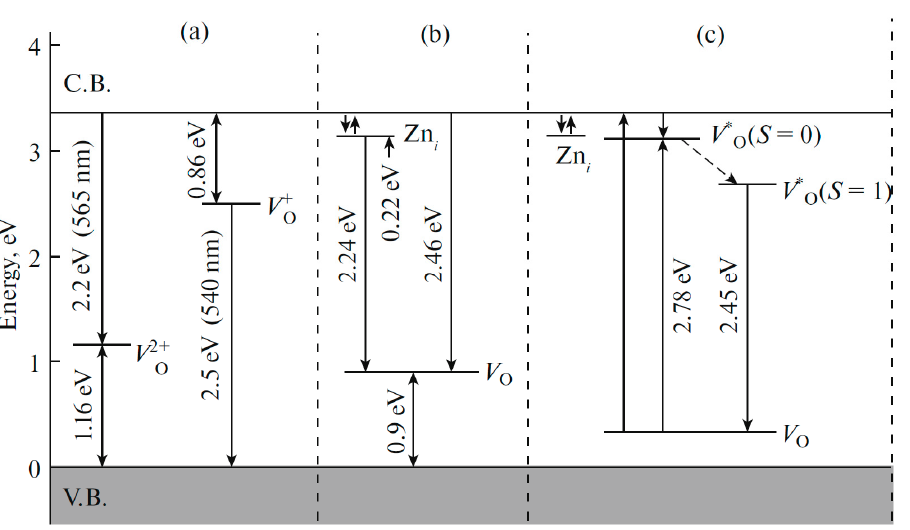
Figure 11. Energy level diagram of ZnO and possible transitions responsible for green luminescence (GL) [51]: ( a ) Luminescence model for films consisting of large or small granules; ( b ) luminescence model for nanoneedles and polycrystals; ( c ) a model of triplet-singlet transitions of V 0 o centers as explanation of the GL [52–59].